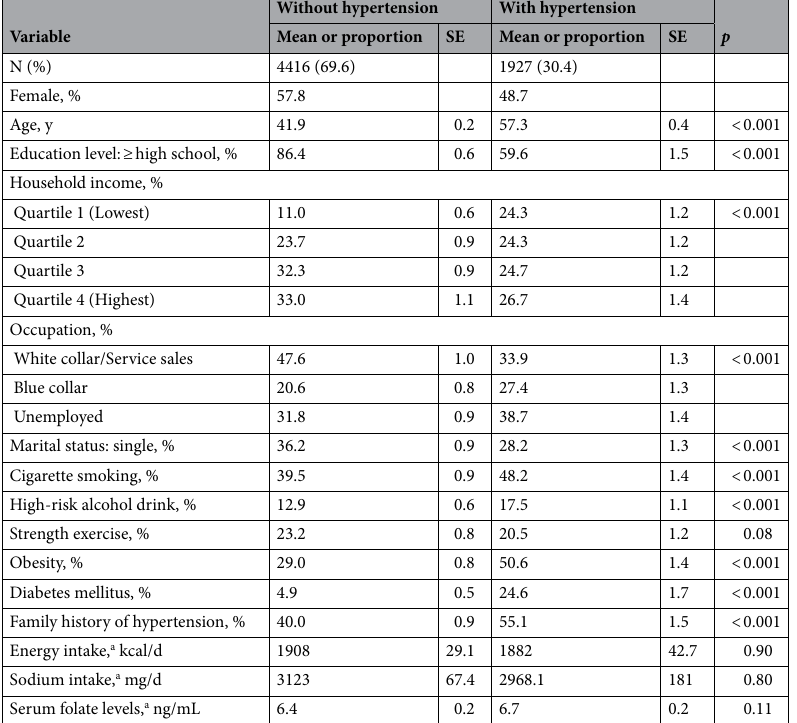
Table 1. Characteristics of study participants. a Data present median and SE.